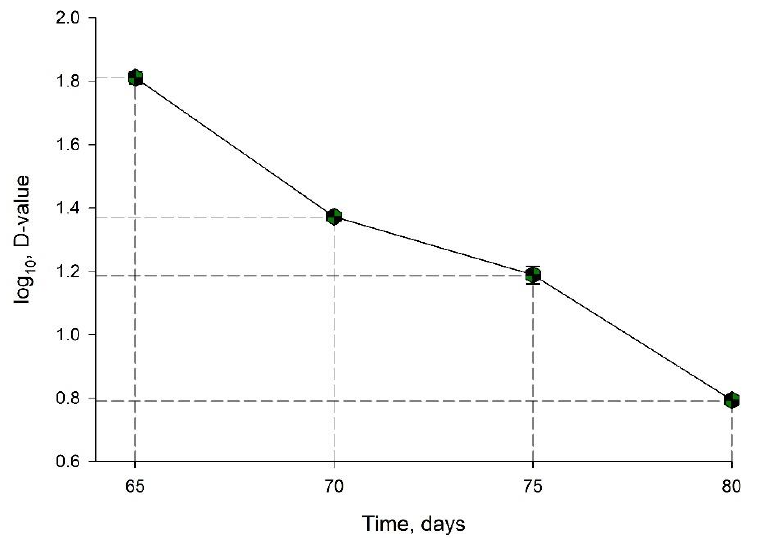
Figure 6. Thermoresistance curve for the mixture of Salmonella spp. in feed for